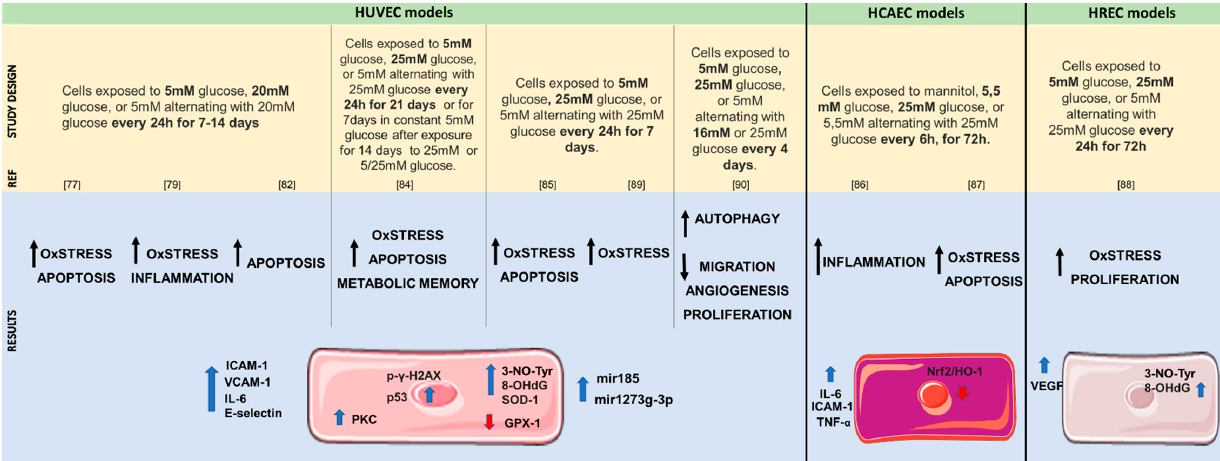
Figure 2. In vitro endothelial models used the effects of glucose in the cardiovascular system and the respective obtained results. HUVEC: human umbilical vein endothelial cells; HCAEC: human coronary artery endothelial cells; HREC: human retinal endothelial cells.